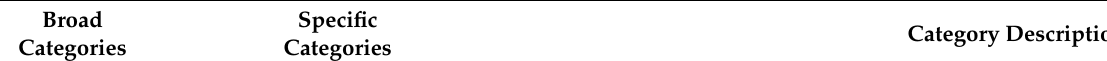
Table A1. Categorization of free-text